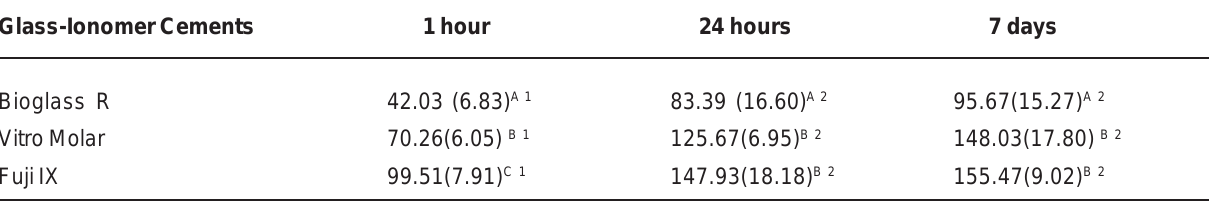
TABLE 2- Mean Compressive Strength (CS) of GIC’s in MPa and standard deviations (SD)